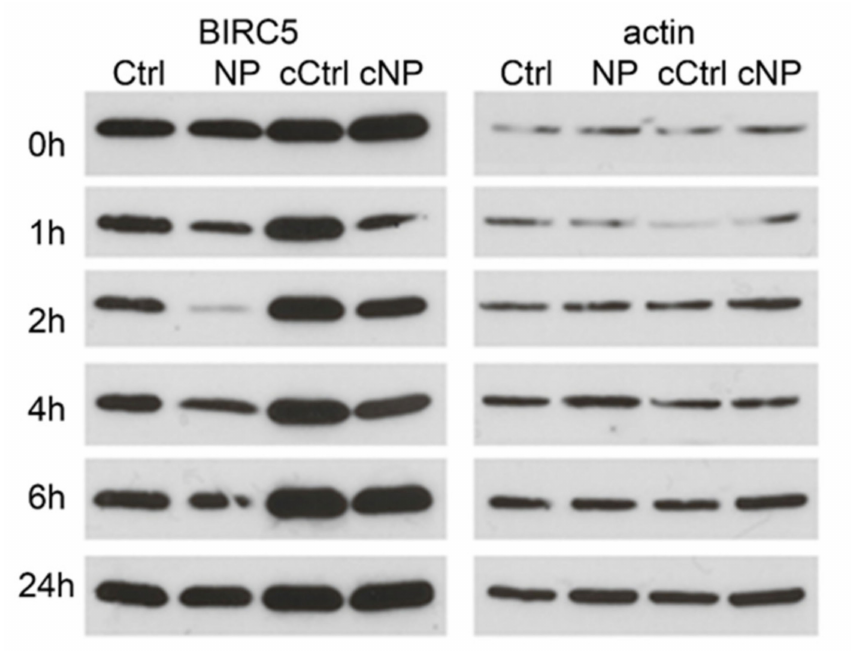
Figure 3. BIRC5 participation in the protein corona on the nanocomposite surface. BIRC5 in whole cell lysates from nanocomposite treated and control cells at different timepoints was evaluated by Western blotting at timepoints indicated. Protein isolates from low cell confluency control (Ctrl) and low cell confluency nanocomposite treated cells (NP) were compared with high confluency control cells (cCtrl) and high confluency nanocomposite treated cells (cNP). Actin protein for the same Western blots is shown on the right-hand side; actin quantity in cells in not affected by cell